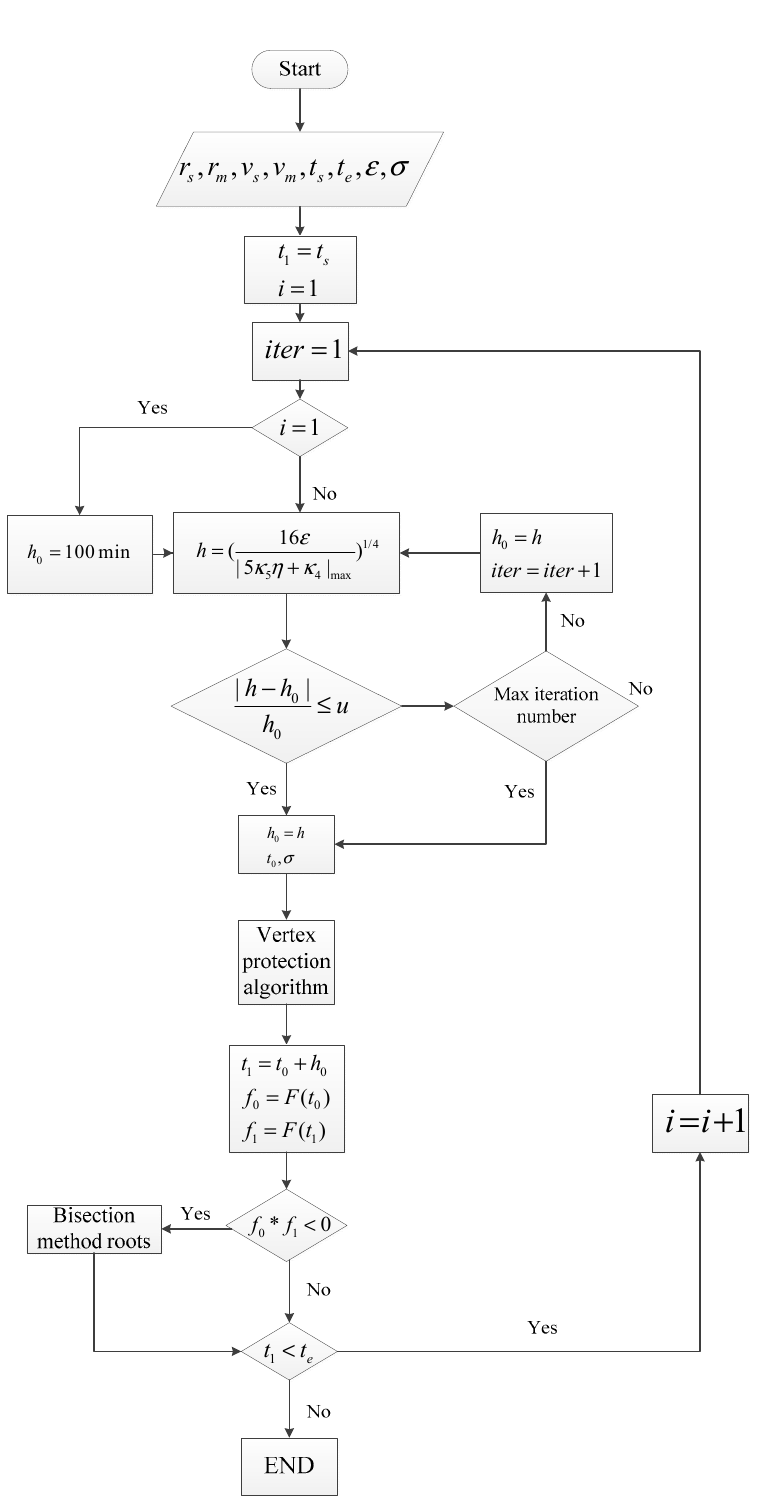
Figure 4. Flowchart of the adaptive interpolation based on the vertex protection